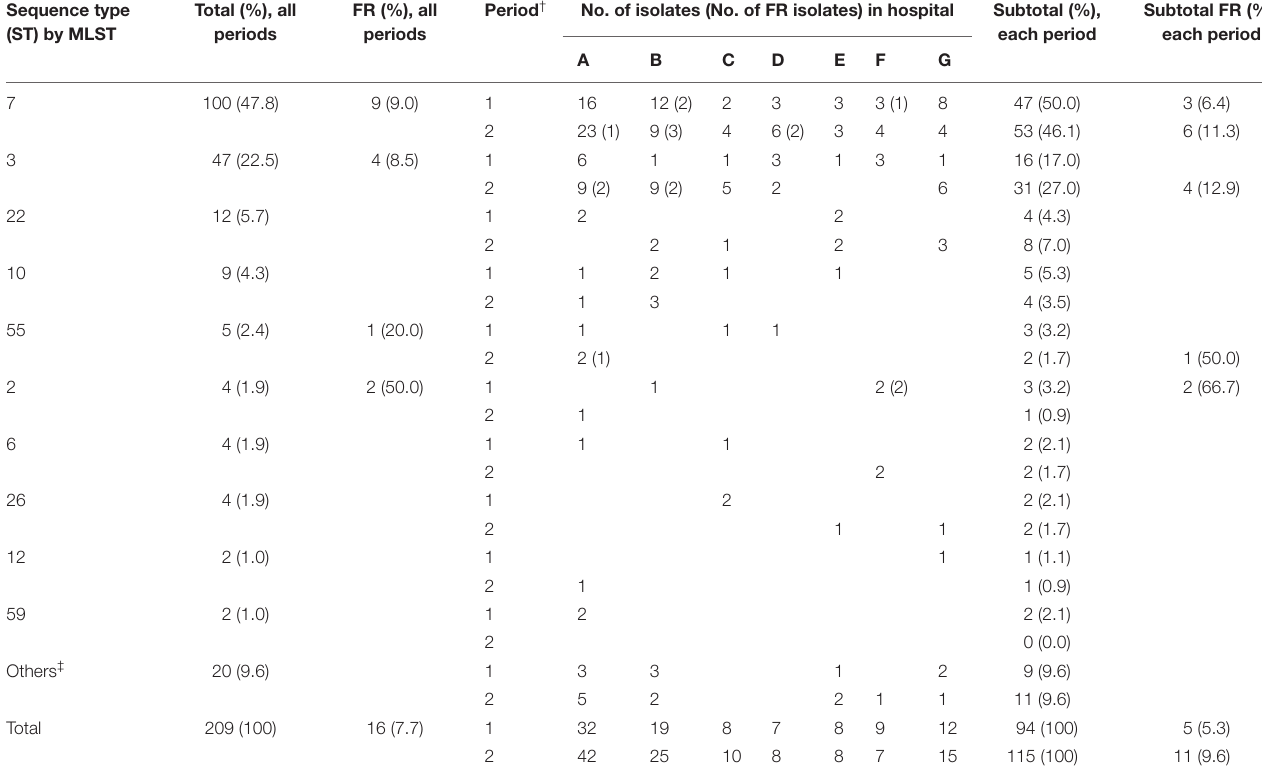
TABLE 1 | Multilocus sequence typing (MLST) and fluconazole resistance (FR) status of 209 Candida glabrata bloodstream isolates from seven Korean hospitals. Sequence type Total (%), all FR (%), all Period † No. of isolates (No. of FR isolates) in hospital Subtotal (%), (ST) by MLST periods periods